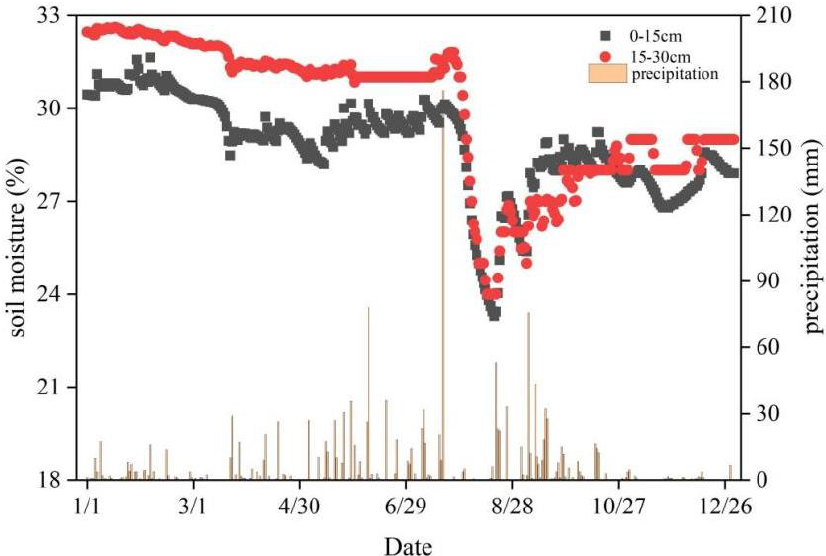
Figure 3. Changes in precipitation and soil moisture in the study area throughout the 2020 observation period. The black dots in the figure represent the soil water content of 0–15 cm, the red dots represent the soil water content of 15–30 cm, and the rectangles represent the precipitation. The water supply status of plants can be judged by the changes in precipitation and soil water content.